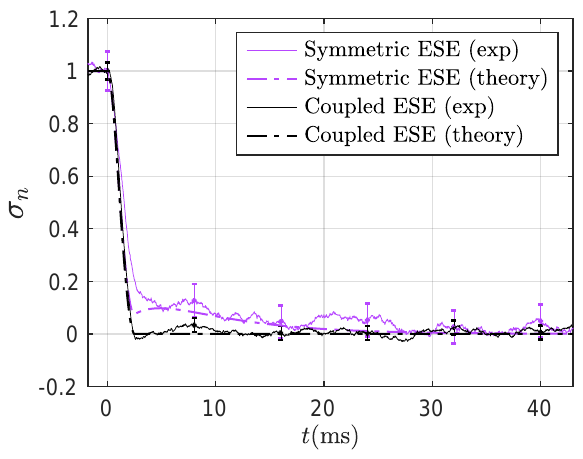
= ( σ ( t ) − σ ) / ( σ − σ ) of the first parti- Figure 6: Normalized variance σ n f i f cle when the potentials are driven by the symmetric protocol (purple) or by the = 1.4, coupled ESE protocol (black). The parameters of the experiment are: k f = K = 1.8 × 10 − 6 N / m, t = 2.5ms, d = 0.8 µ m, and thus ε = 0.49 and K f 1, i 2, i Γ = 4.19. The symmetric protocol leads to the rebound predicted in section 4. On the contrary the coupled protocol designed to cancel the correlations between the particles works as expected: the rebound is essentially suppressed and the particle reaches equilibrium at t . Furthermore, the experimental results (plain lines) are f again consistent with the theoretical predictions (dashed lines) based on measured parameters only and not on adjustable